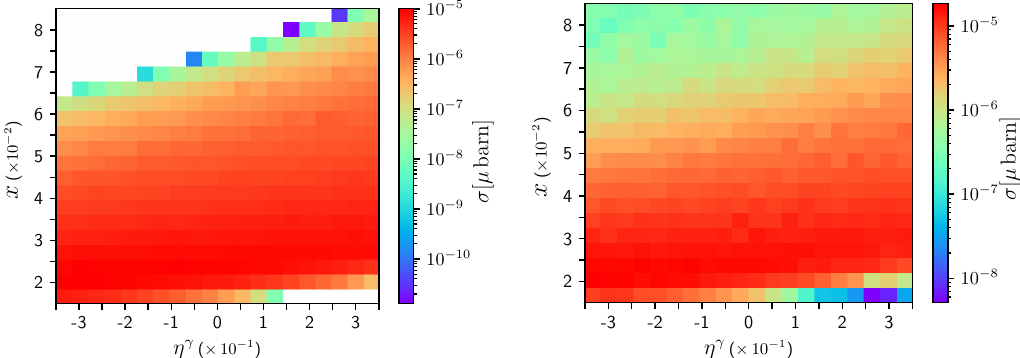
Figure 6: The partonic momentum fraction x = x (right). The color scale shows the cross-section at LO QCD (upper row) and NLO QCD + LO QED (lower row). We simulated the events using RHIC kinematics with (cid:112) = 500 GeV. S CM